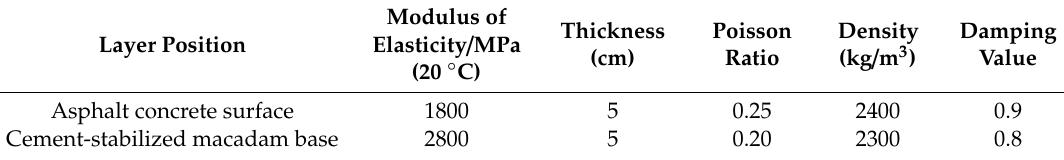
Figure 3. Schematic geometry of the model. Table 1. Material parameters of specimens.